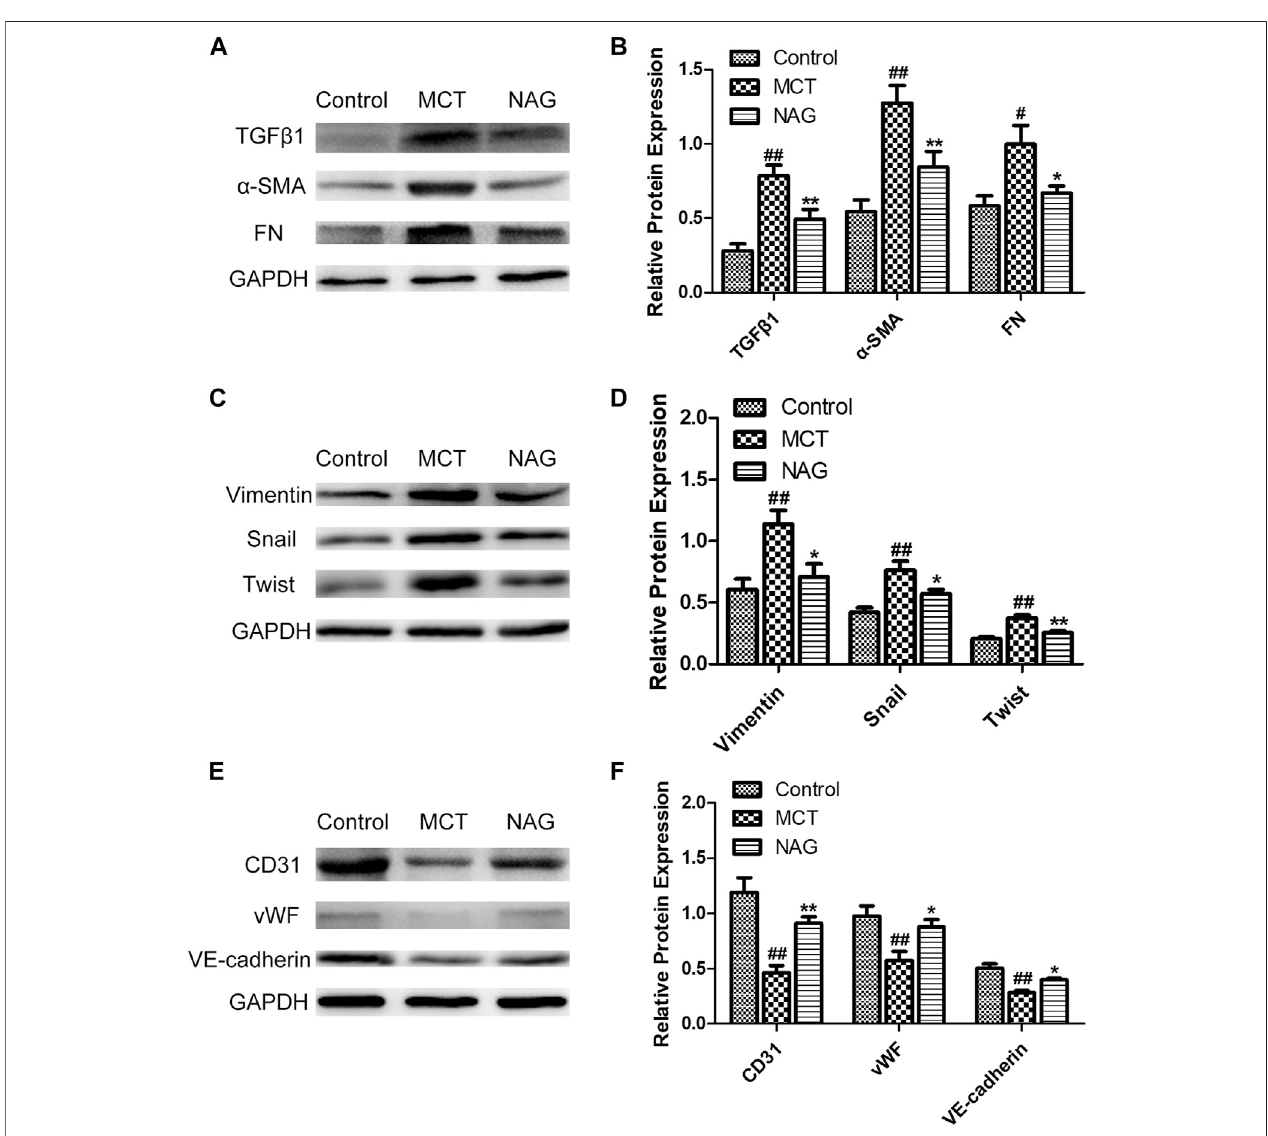
FIGURE 4 | Effects of naringin on expressions of TGF β 1, α -SMA, FN, Vimentin, Twist, Snail, CD31, vWF, and VE-cadherin in lung tissues in rats. Expressions of TGF β 1, α -SMA, FN (A,B) , Vimentin, Twist, Snail (C,D) and CD31, vWF, VE-cadherin (E,F) . # p < 0.05, ## p < 0.01 vs. control; * p < 0.05, ** p < 0.01 vs. MCT. n (cid:1) 6.